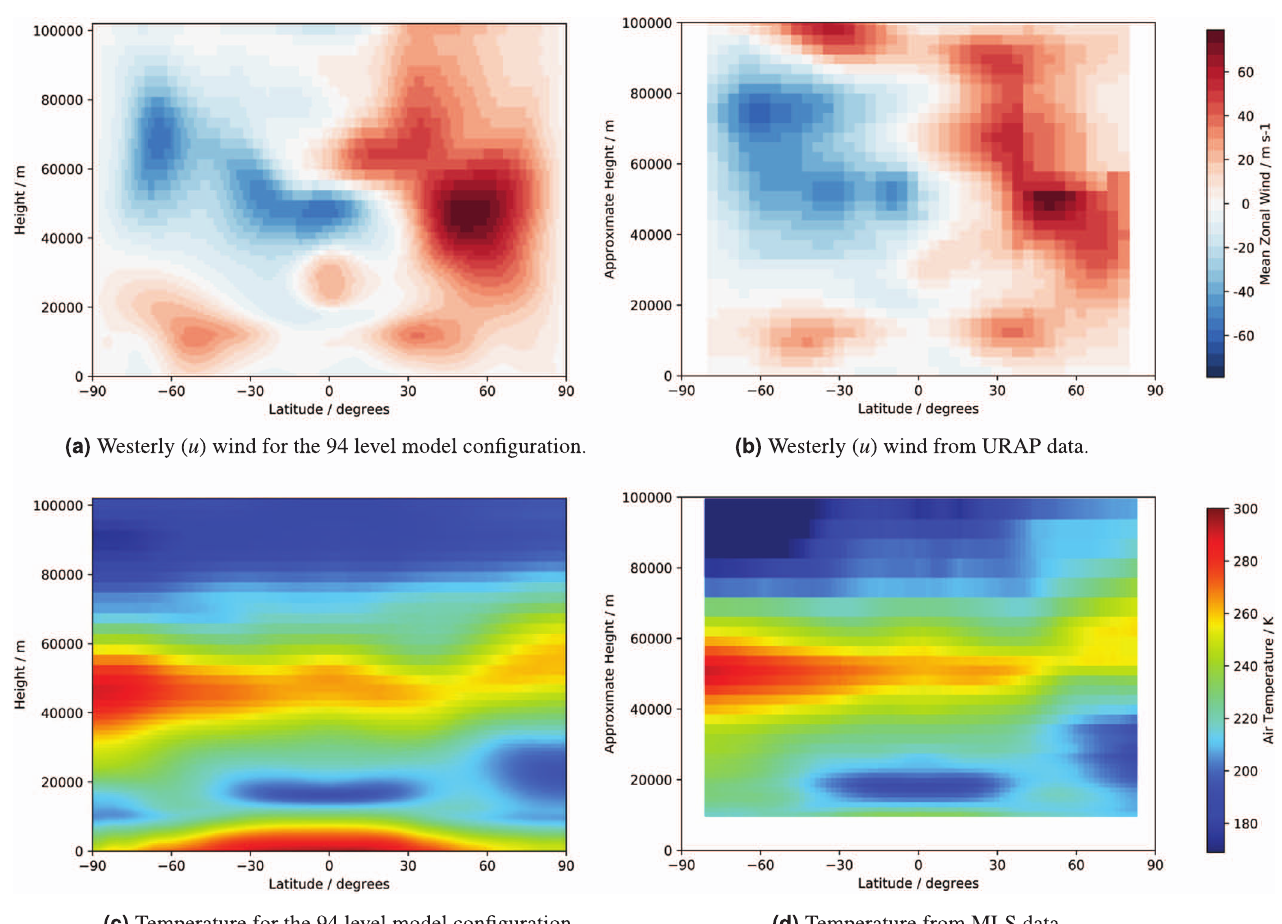
Fig. 14. Zonal mean monthly mean climatologies in December of westerly ( u ) wind (top) and temperature (bottom). These are compared to URAP data for zonal wind and MLS data for temperature. The approximate height is calculated using a scale height of H = 7200